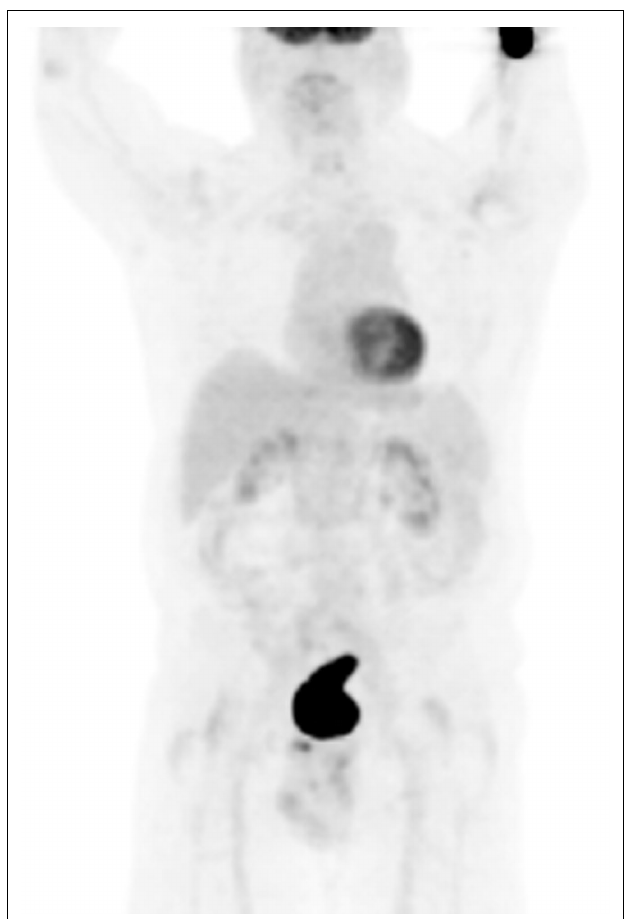
FIGURE 4 | Maximum intensity projections PET image (LWB FOV) of a patient with a history of lung cancer. Dose extravasation in the LAC at the edge of the image field with SUVmax